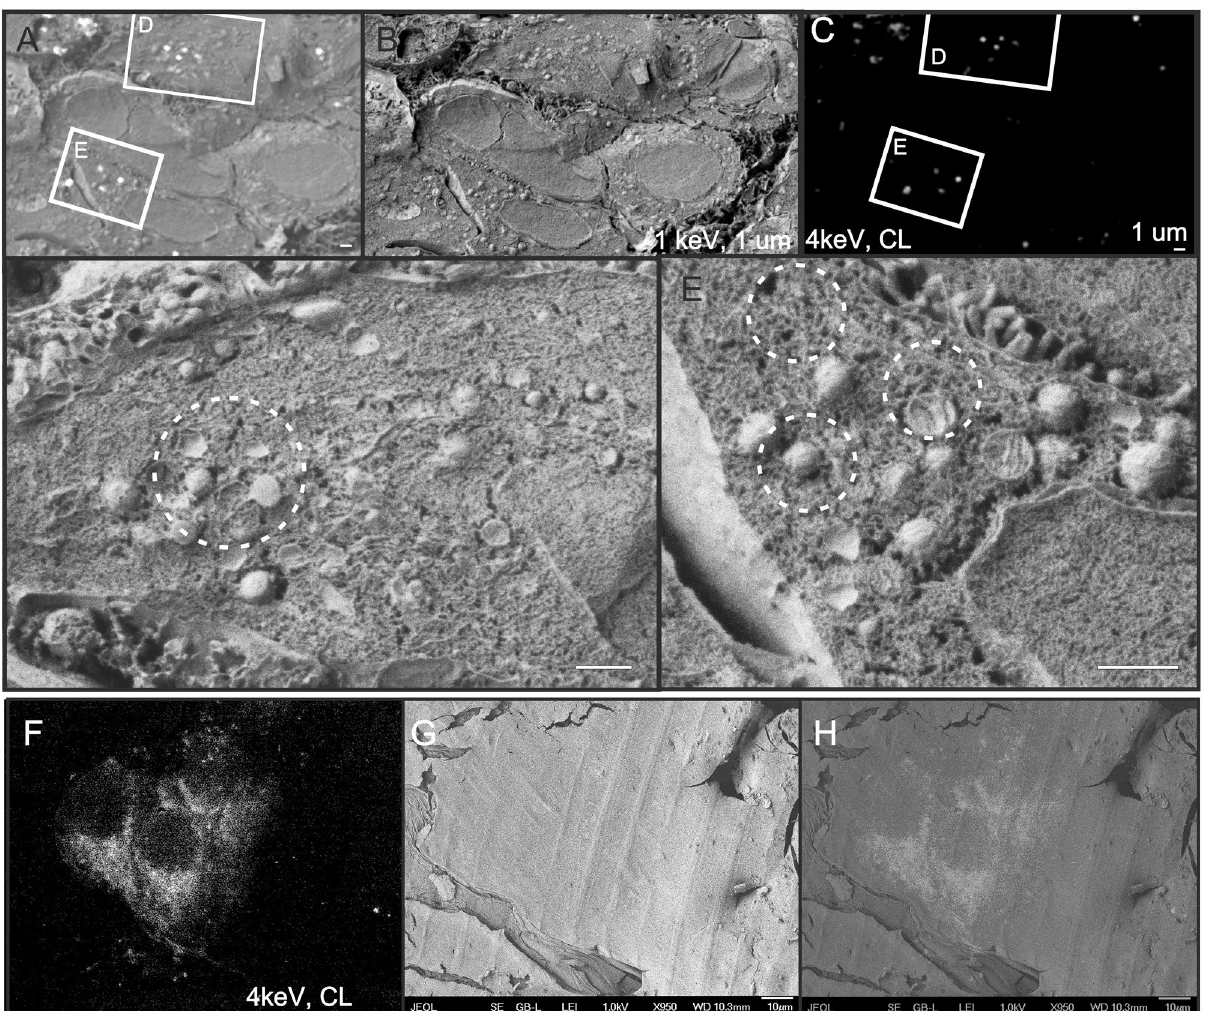
Figure 3. Correlative cryo-cathodoluminescence (CL) scanning electron microscopy of Vero cells stained with IRAZOLVE-MITO. ( A – E ) In vivo stained cells were frozen, fractured, and imaged at − 135 °C using Crytur CL detector (4 keV) and the Everhart–Thornley detector (ETD, 1 keV). ( F – H ) Chemically pre-fixed cells were stained, frozen at high pressure, and corresponding images were taken at 4 keV using CL ( F ) and ETD ( G ). Bars: 1 µm ( A – E ), 10 µm ( F – H ). SEM JEOL 7401F. CL and topographic images were merged manually ( A , H 10 mM (stock solutions). Cells were stained in the presence of culture media by adding either the REZOLVE- ER stock solution (to final concentrations of either 33 or 50 µM) or IRAZOLVE-MITO (20 µM, 40 µM). Cells were imaged in vivo by a holographic microscope 3D Cell Explorer (Nanolive) either after 30 min or overnight incubation. In the case of IRAZOLVE-MITO staining, the cells were stained and imaged after fixation in 4% formaldehyde in 0.1 M HEPES for 1 h at room temperature, followed by a 30 min wash step. Cryo-scanning electron microscopy and CL imaging. Pelleted cells were high pressure frozen (EM ICE, Leica Microsystems) in the presence of 20% bovine serum albumin and transferred into the scanning electron microscope (SEM) JEOL 7401F (JEOL Ltd.) equipped with a cryo-attachment CryoALTO 2500 (Gatan, Inc.) precooled to − 140 °C. Cells were freeze- fractured, optionally freeze-etched at temperatures between − 98 °C and − 95 °C for 10 s, and gold-coated for 10 s with gold (~ 2 nm). Images were taken using the Everhart– Thornley detector of secondary electrons and the CL detector designed by Crytur comp. The CL detector detects panchromatic CL signals with a high signal-to-noise ratio in the spectral range 330–600 nm. This retractable CL detector of the parabolic mirror type consists of a quartz light guide and the photomultiplier. The contrast and brightness settings of the CL detector during CL intensity measurements were constant. Independent observation was performed using the SEM Magellan 400L (ThermoFisher Scient.) equipped with MonoCL4 + CL detector (Gatan, Inc.) at a range of temperatures from − 125 °C to − 150 °C. Freeze fracturing and Au/Pt coating (appr. ~ 2.7 nm) was performed using the sputter coater Leica ACE 600 (Leica Microsystems). CL images and spectra were taken at a beam energy of 7 keV and probe current of 0.1 nA.